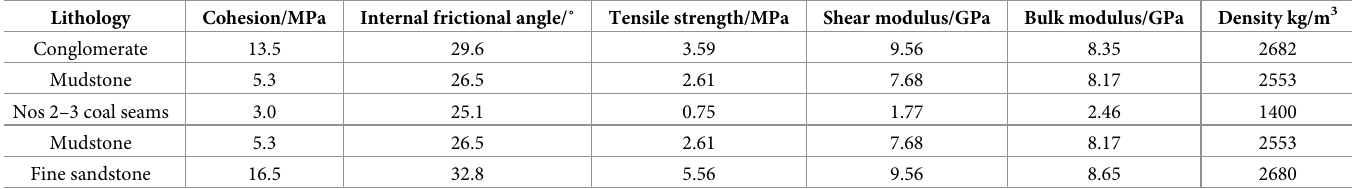
Table 5. Physico-mechanical parameters of coal and surrounding rock.